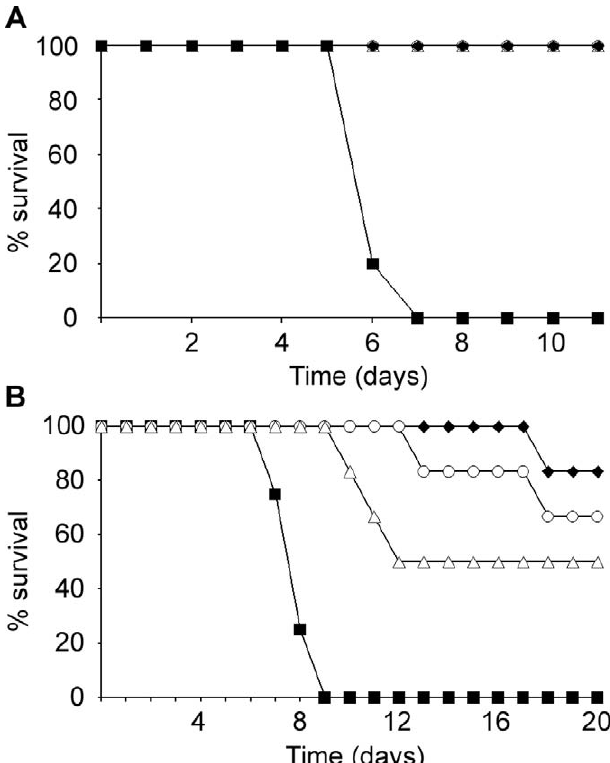
Figure 1. Kaplan-Meier Survival Curves for Mice and Guinea Pigs Given Post-Exposure Treatment for ZEBOV Infection (A) Mice (groups of five animals) were infected with 1,000 LD 50 of MA-ZEBOV by i.p. injection. At various times points 24 h prior to challenge ( * ), 30 min after challenge ( ¤ ), or 24 h after challenge ( n ) they were treated with 2 3 10 5 pfu of VSV D G/ZEBOVGP by i.p. injection. The controls ( & ) were left untreated and all died. All treated animals survived the challenge. (B) Guinea pigs (groups of six animals) were infected with 1,000 LD 50 of GA-ZEBOV by i.p. injection. At various times points 24 h prior to challenge ( * ), 1 h after challenge ( ¤ ), or 24 h after challenge ( n ) they were treated with 2 3 10 5 pfu of VSV D G/ZEBOVGP by i.p. injection. The controls ( & ) were left untreated and all died.